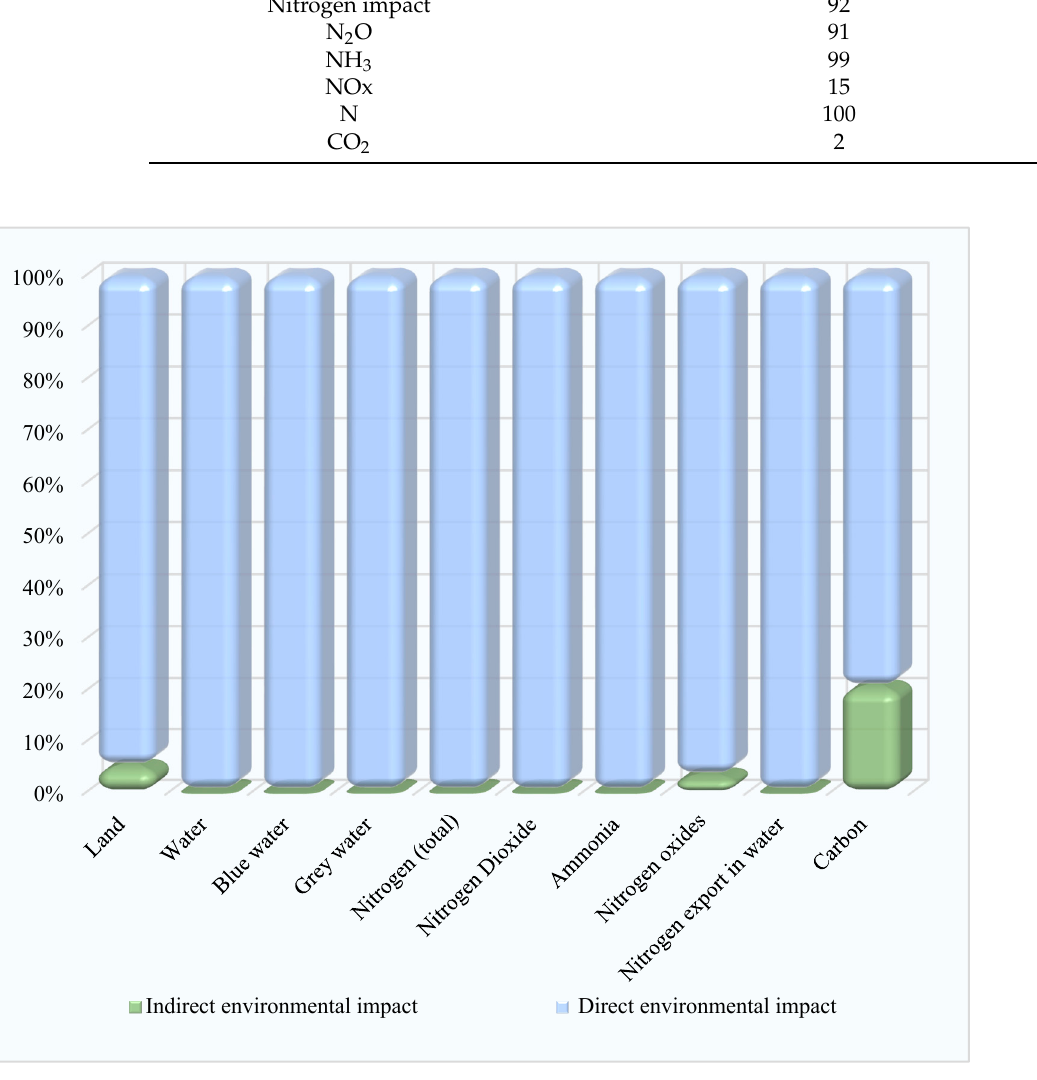
Figure 2. A comparison of Pakistan’s agriculture sector’s total direct and indirect environmental impacts.